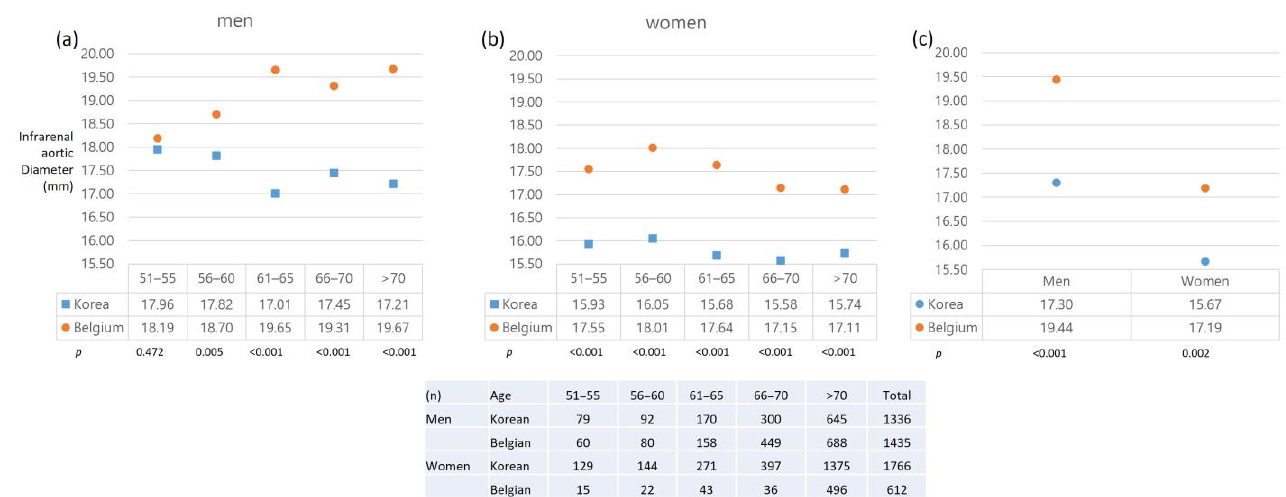
Figure 4. Comparison of the aortic diameter between the Korean and Belgian cohorts: ( a ), Infrarenal aortic diameter in men according to the age group; ( b ), Infrarenal aortic diameter in women according to the age group; ( c ) mean aortic diameter in men and women.